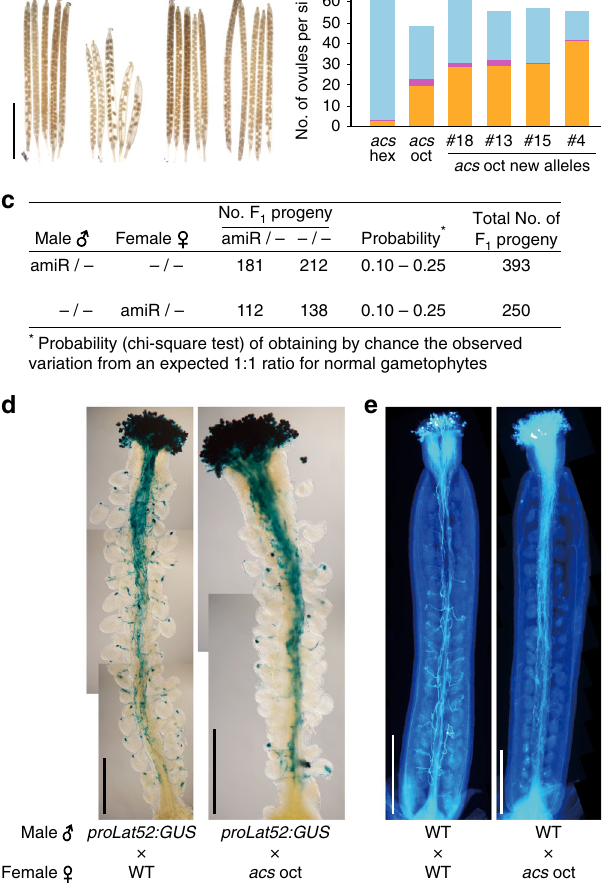
Fig. 1 The female sporophyte of the acs octuple mutant is defective in pollen tube targeting. a Representative siliques of the acs octuple (oct) mutant, wild type (WT), and ethylene-insensitive mutants ( ein2-5 and etr1-1 ). Scale bar, 5mm. b Average number of post-pollination ovule fates per silique in the original acs oct mutant 7 and four independently generated acs oct mutant alleles compared to their genetic background, the acs hextuple (hex). n = 5 siliques per genotype, except n = 6 for Line 18. (For statistical data see Supplementary Fig. 1e – g.) c Reciprocal crosses between WT and the hemizygous amiRNA line. n = 10 crosses in each direction. d Representative GUS staining of WT pollen tubes expressing LAT52:GUS in dissected hand-pollinated pistils of the WT versus acs oct mutant. A dot of GUS staining within the ovule indicates fertilization by the pollen. Scale bar, 500 μ m. e Representative images of aniline blue-stained WT pollen tubes